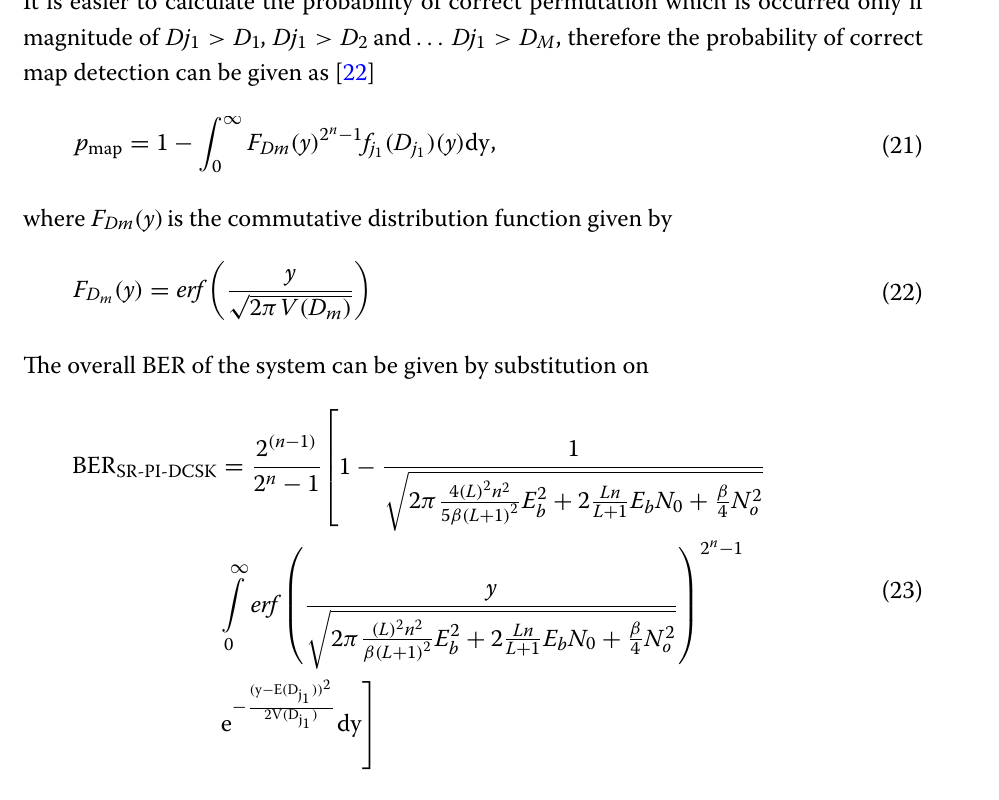
Table 3 Receiver system complexity analysis (for one information bit) Unit DCSK CDSK HE-DCSK TR-DCSK SR-PI-DCSK Multipliers Delay a DMU data mapping unit (including the time reversal unit)